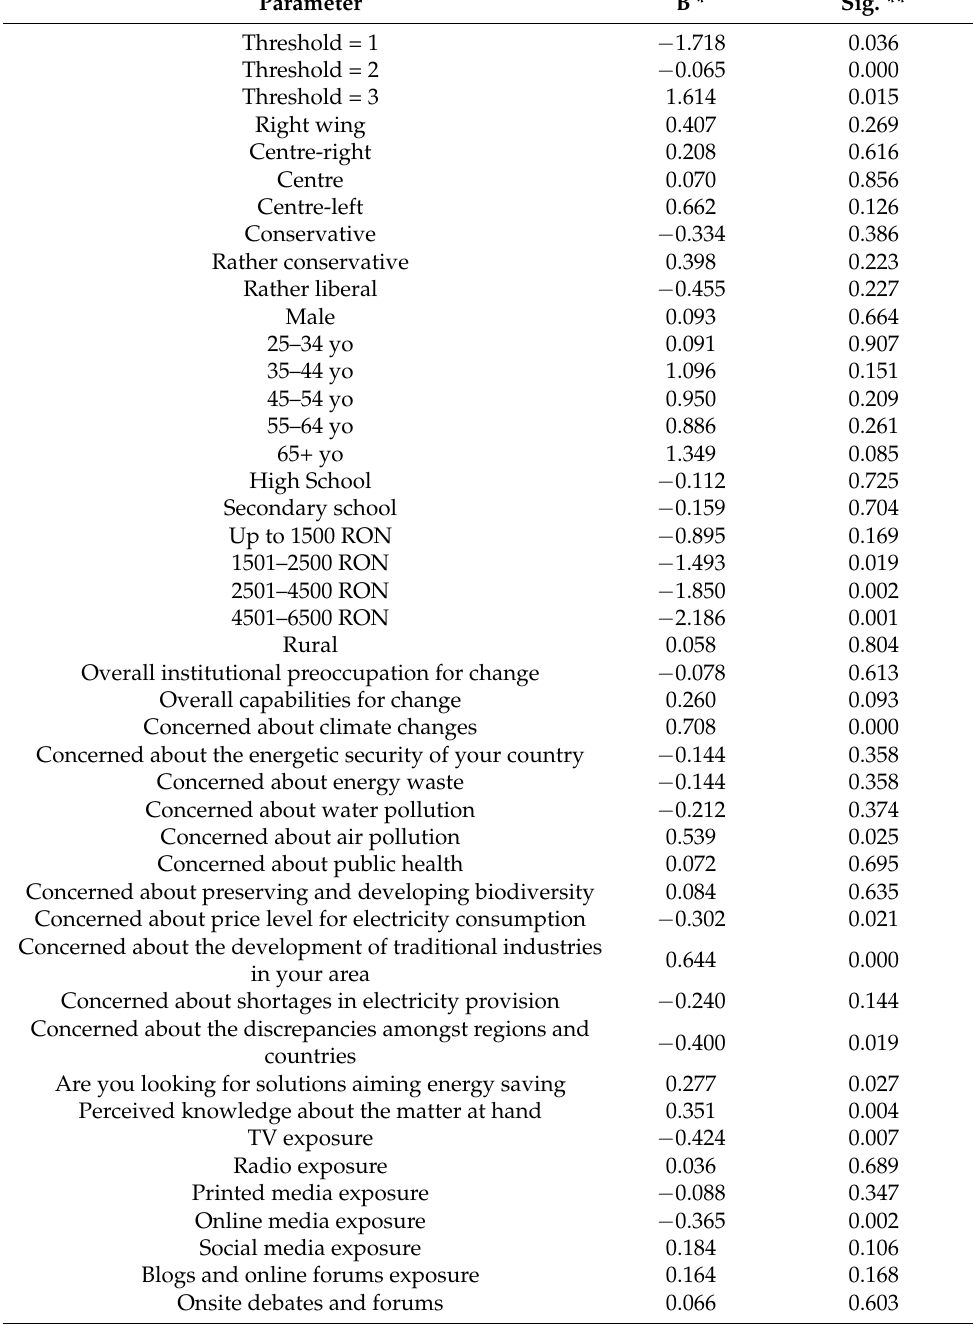
Table 9. Results of the ordinal logistic regression. Q: From your point of view, should Romania give up on traditional electricity production (coal, fossil, etc.) and move towards production based on renewable energy sources (wind, photovoltaic,